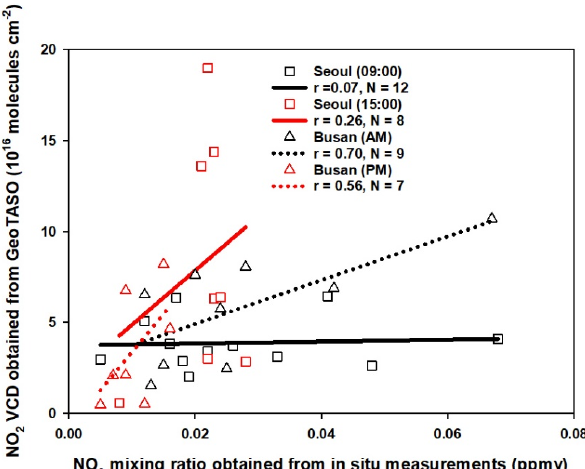
Figure 11. Scatter plot of the NO 2 VCDs retrieved from GeoTASO and the NO 2 surface mixing ratio obtained from Air-Korea. The black and red squares represent the NO 2 data at 09:00 and 15:00LT in the Seoul metropolitan region, respectively. The black and red triangles represent those in the morning and afternoon over Busan,